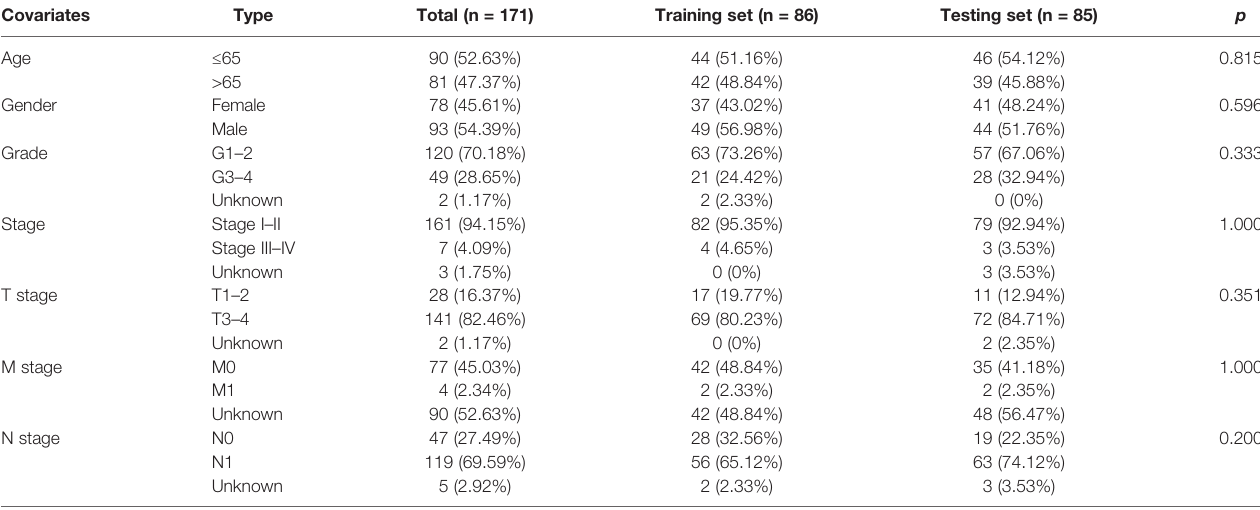
TABLE 2 | Comparison of clinicopathological features between the training set and testing set.